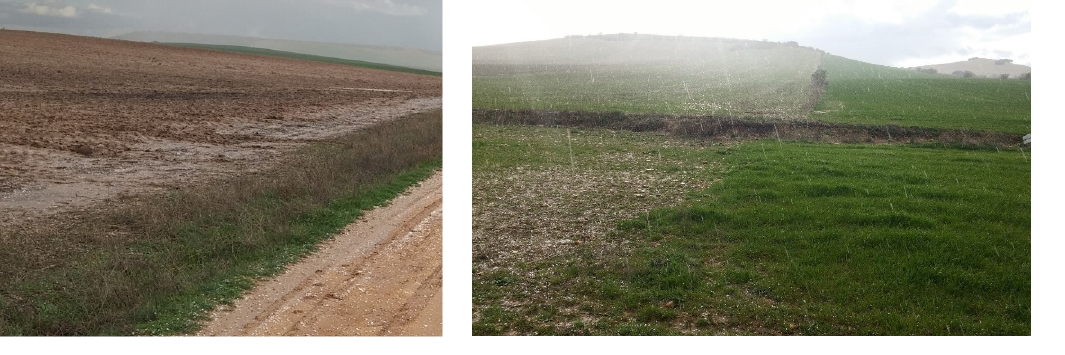
Image 3: Sedimentation processes. Example of a dark Image 4: Covered land with slight elevation. Example of a green area light green area Figure 13. Selection of field visit pictures from the period STM-1 (28 February–6 March 2018). The sites pictured are marked in Figure 12 STM-1 and were taken from the circle pointing to each callout.